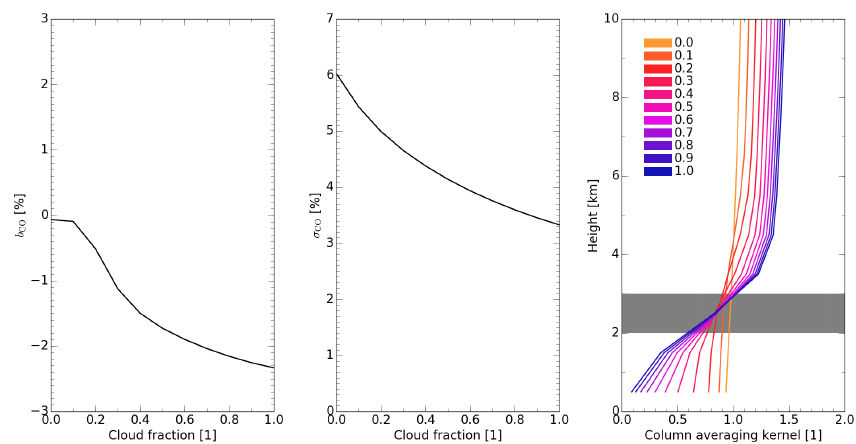
Figure 4. Example of the S5P CO data product and its performance as a function of cloud fraction f cld . The SWIR measurements are simulated for a scene partially covered by a cloud between 2 and 3km with optical depth τ cld = 5, a surface albedo A s = 0 . 05, a solar zenith angle of 50 ◦ and a viewing zenith angle of 40 ◦ . Left panel: CO retrieval bias b CO . Middle panel: retrieval noise σ CO . Right panel: column averaging kernel for different cloud fractions as indicated in the legend. The gray area indicates the position of the cloud.